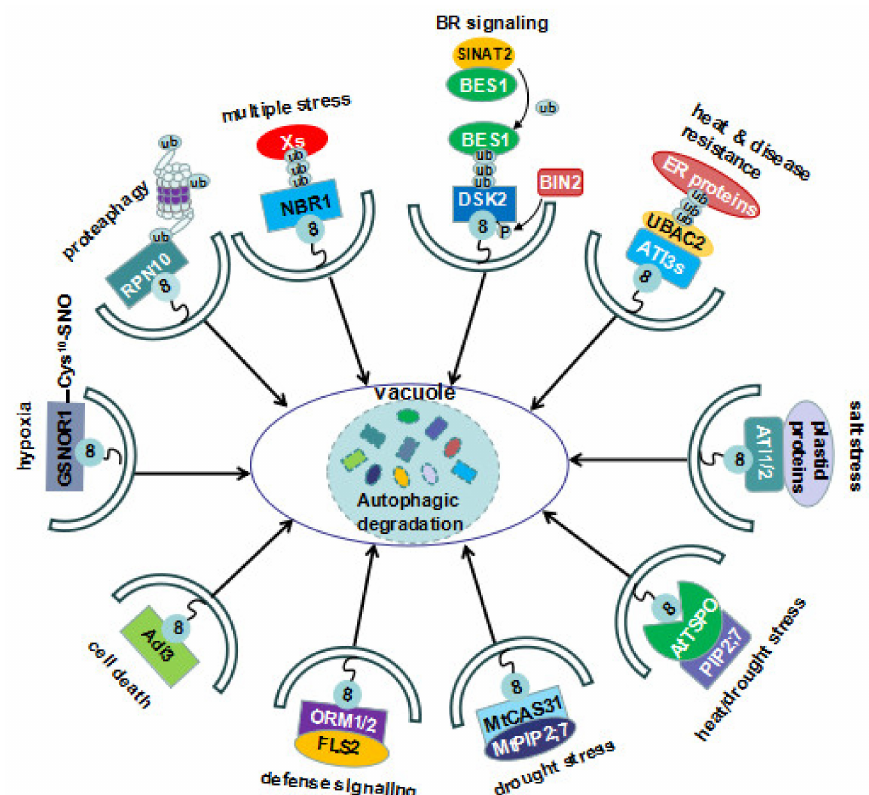
Figure 1. The cargoes and the receptors of selective autophagy identified in plants that are involved in various stress responses. Cys 10 –SNO represents the S-nitrosylation at Cys 10 under hypoxia conditions. This modification induces the conformational changes of S-nitrosoglutathione reductase 1 (GSNOR1), enabling its ATG8-interacting motifs (AIM) to be exposed and accessible for ATG8 binding. Neighbor of BRCA1 (NBR1), Dominant suppressor of KAR 2 (DSK1), and Ubiquitin-associated domain2 (UBAC2) mediate the autophagic degradation of polyubiquitinated cargoes; three ubiquitin moieties represent polyubiquitination; Xs represents multiple polyubiquitinated proteins or protein aggregates that were induced under stress conditions; BRI1-EMS suppressor 1 (BES1) is firstly polyubiquitinated by Seven in absentia of Arabidopsis 2 (SINAT2), a Really interesting new gene (RING)-type E3 ligase, and the polyubiquitinated BES1 is recruited to the autophagosome by interacting with DSK2; DSK2 is phosphorylated at the sites flanking the two AIMs within its amino acid sequence. This modification results in the increased interaction between DSK2 and